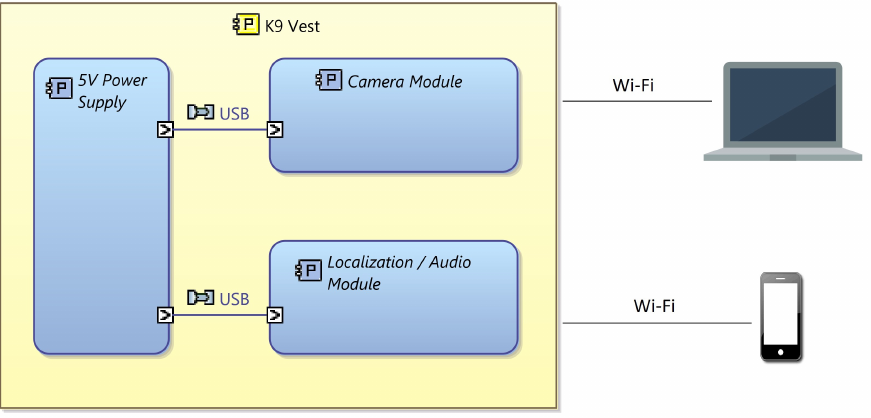
Figure 1. The K9 Vest block